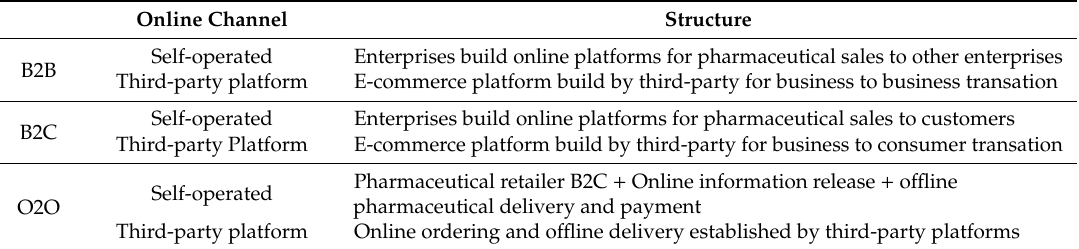
Table 2. Online pharmaceutical supply chain